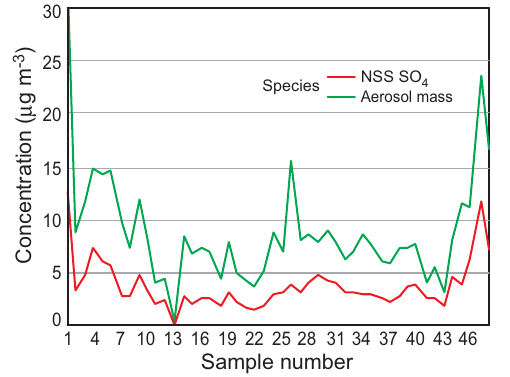
3 Figure 4 : Time series of the aerosol dry mass and NSS sulfate concentration over the study 4 Fig. 4. Time series of the aerosol dry mass and NSS sulfate concen- period. 5 6 tration over the study period.